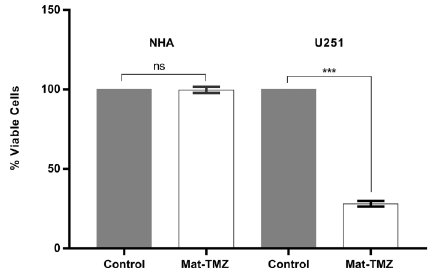
Figure 2. Tumor (U251) and normal (NHA) cell viability after 72 h of treatment with matteucinol-temozolomide (Mat-TMZ) (28 m g/mL Mat and 9.71 m g/mL TMZ). The assay was performed in experimental triplicates and two independent experiments. The negative control used was 1% DMSO. Data are reported as means ± SD. ***P=0.0003 (Student ’ s t -test). ns: not signi fi